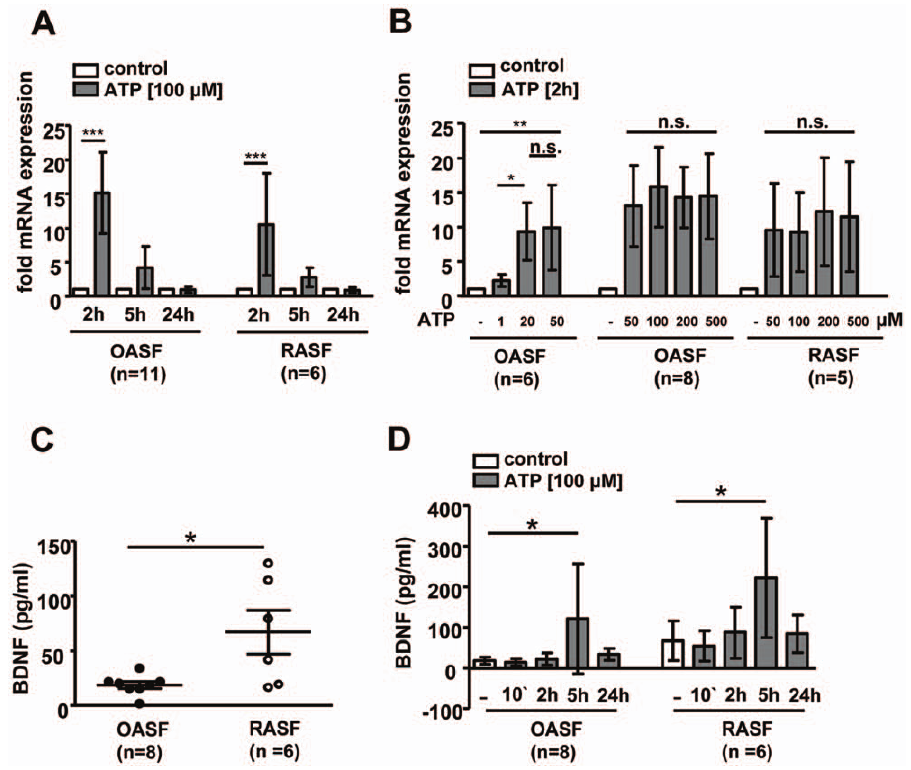
Figure 1. ATP-induced BDNF expression in SF. OASF (n=11) and RASF (n=6) were stimulated with ATP (50, 100, 200, 500 m M) for 10 minutes, 2 h, 5 h and 24 h. A. BDNF mRNA levels were induced 2 h after ATP stimulation. B. Influence of different ATP concentrations on the induction levels of BDNF mRNA after 2 h ATP stimulation. C. BDNF protein levels in cell culture supernatants of unstimulated OASF (n=8) and RASF (n=6) were measured by ELISA. D. BDNF protein levels in cell culture supernatants of OASF and RASF were elevated 5 h after ATP stimulation. Data are shown as means 6 standard deviations. N.s., not significant; *, p , 0.05, ***, p , 0.001.